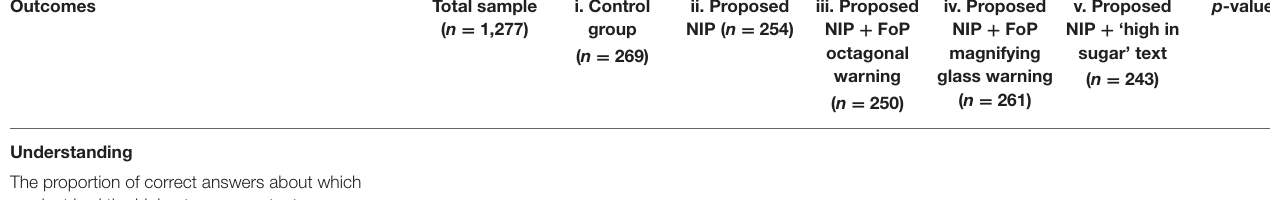
TABLE 2 | Participants’ understanding of the sugar content of the products and their perceived understanding of the labels [ n (%)], by study arm ( n = 1,277). Outcomes